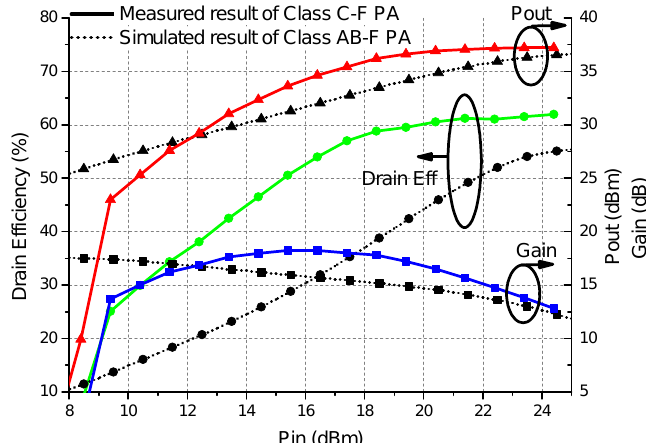
Figure 13. Comparison between simulated class-AB-F PA and measured class-C-F PA.